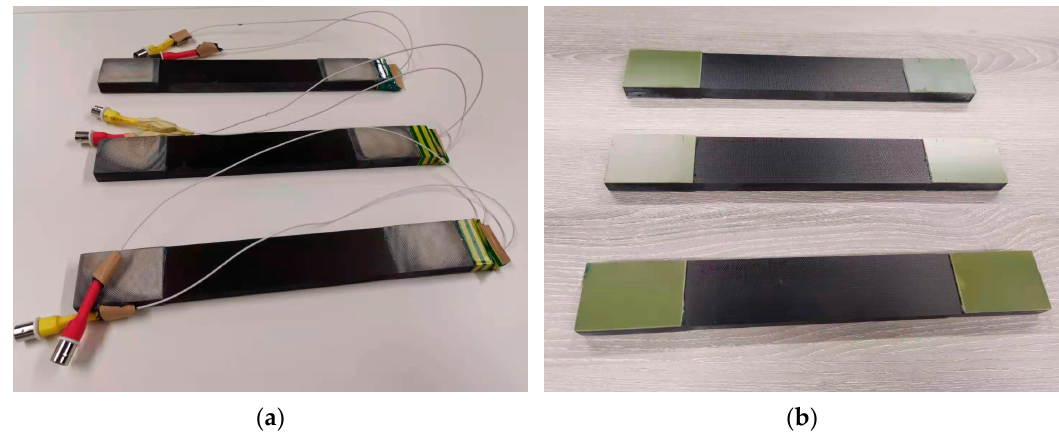
Figure 3. Examples of ( a ) coupons with embedded PZT transducers and ( b ) standard coupons.